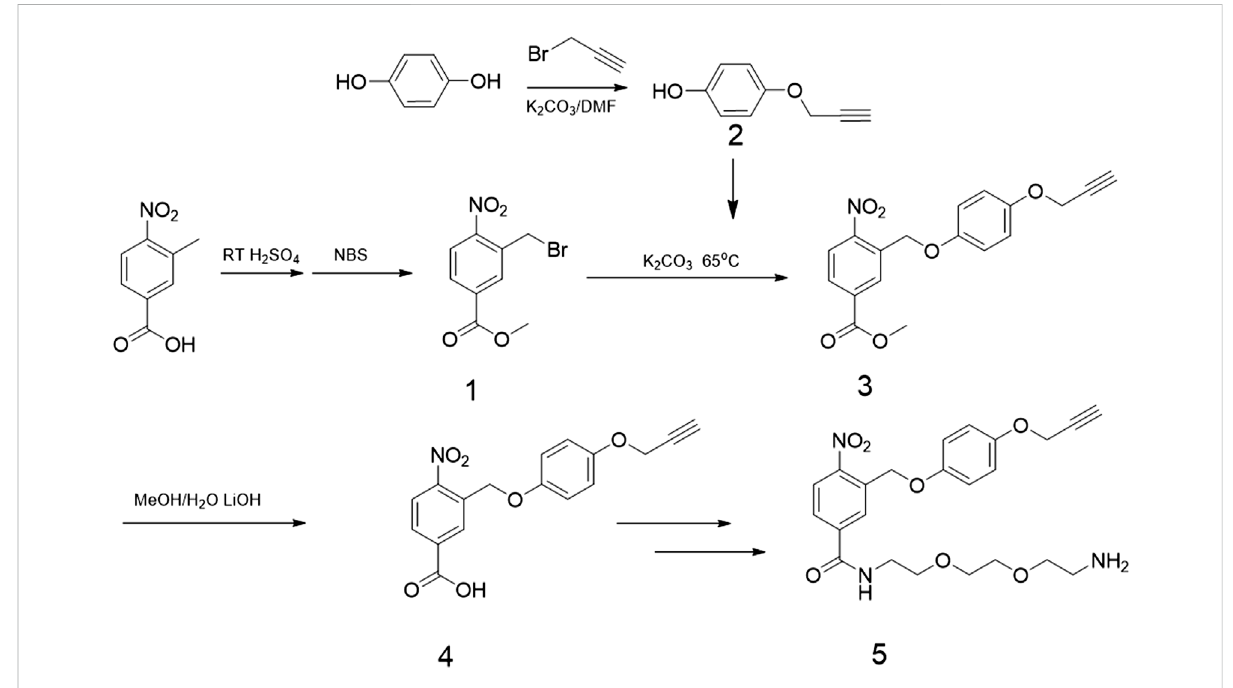
FIGURE 2 Synthesis routes of photo responsive